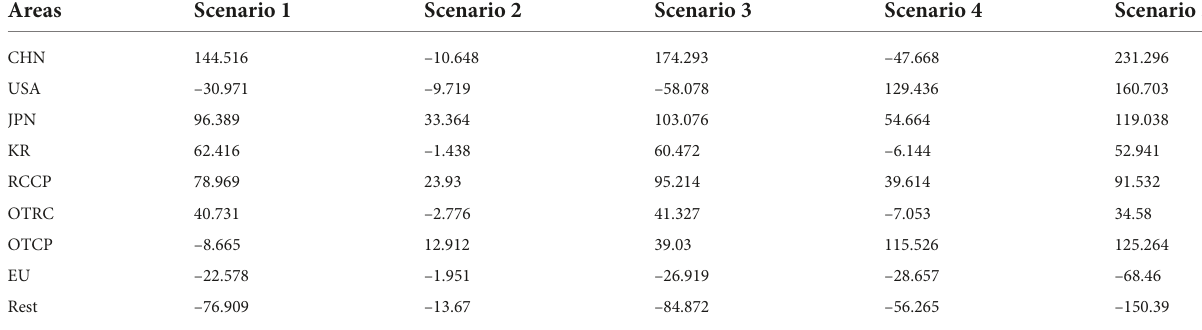
TABLE 7 Impact on social welfare (United States $